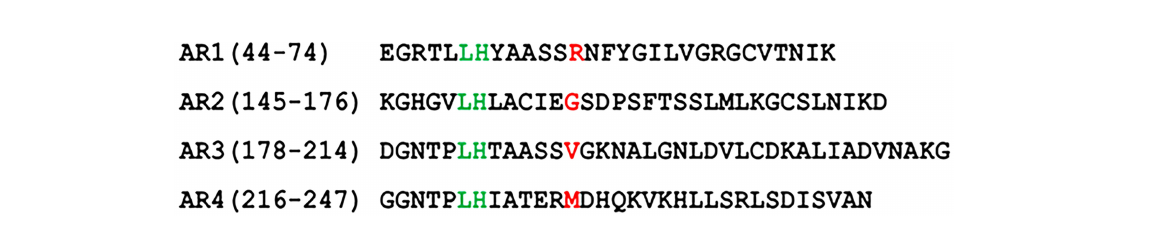
FIGURE 1 | Amino acid sequences of N-terminal ankyrin repeats (AR) of A. phagocytophilum AnkA (WP_020849331.1). Point mutation of the amino acid at 13 th position tested for each AR in the study is marked in red. In AR1 the hydrophilic Arg was replaced with hydrophobic Ala (AnkA.R56A) or neutral/aliphatic Gly (AnkA.R56G). In AR2 the neutral/aliphatic Gly was replaced with hydrophobic Ala (AnkA.G157A) or hydrophilic Arg (AnkA.G157R). In AR3 the hydrophobic Val was replaced with hydrophilic Asn (AnkA.V190N) and in AR4 the hydrophobic Met was replaced with hydrophilic Arg (AnkA.M228R). Numbers in brackets show location of the corresponding ARs in full-length AnkA protein of A. phagocytophilum Webster T strain. For proper alignment, the lysine-histidine pair conserved in all ARs is marked in